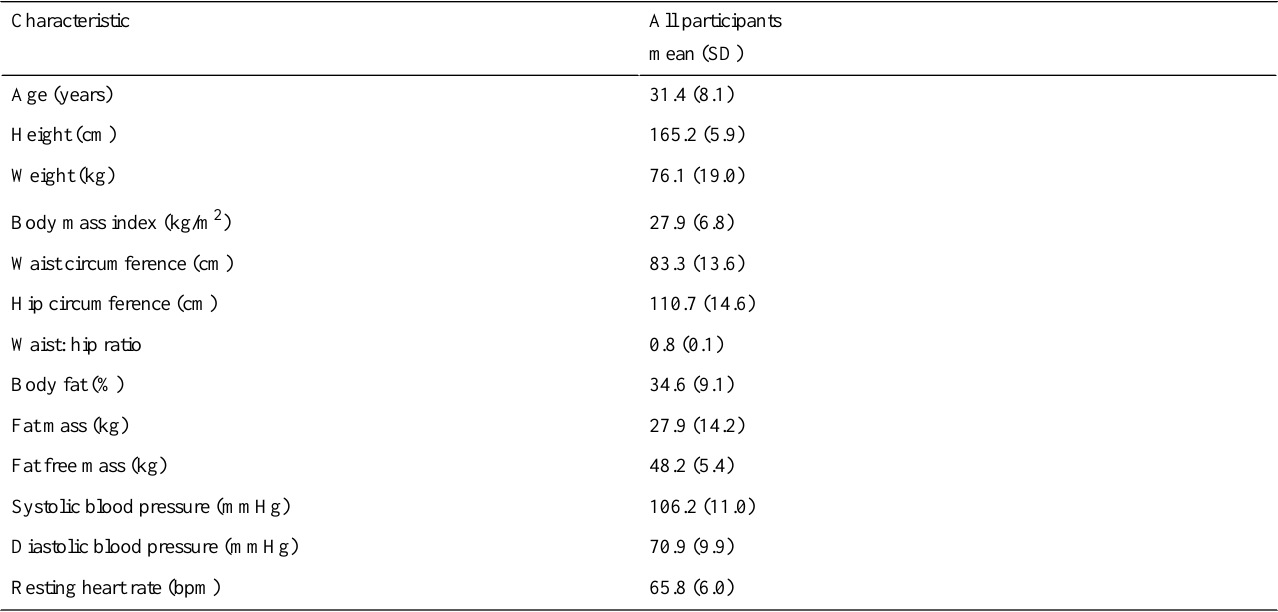
Table 1. Baseline characteristics of women (n=81) participating in a 12-month weight gain prevention intervention and completing baseline testing.